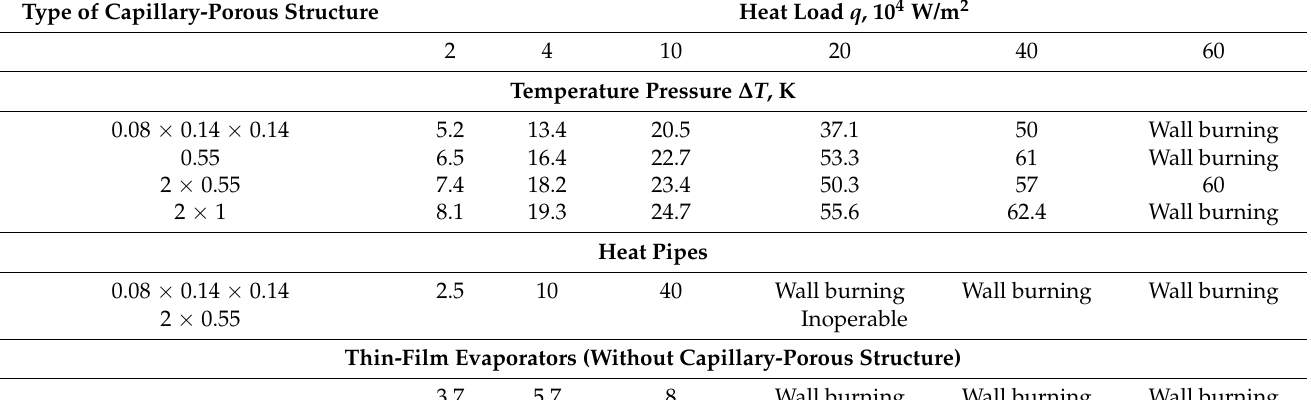
Table 2. Thermal transfer capabilities of q cr investigated capillary-porous structures, heat pipes and thin-film evaporators. Type of Capillary-Porous